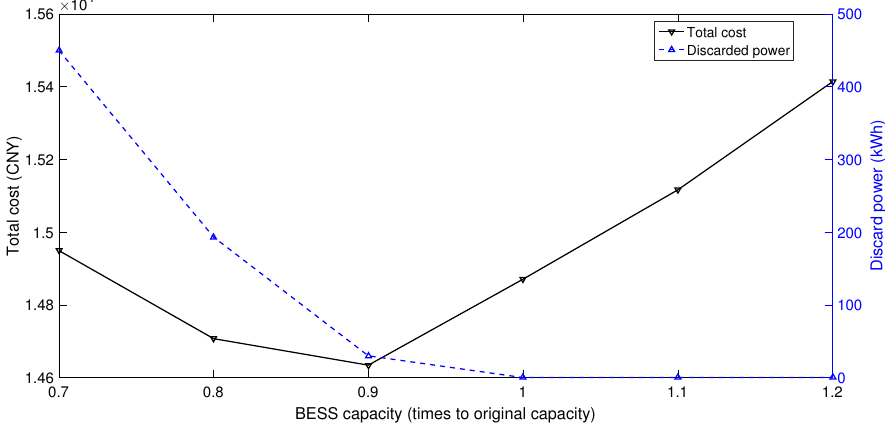
Figure 11. Sensitivity analysis for the different capacities of BESS.